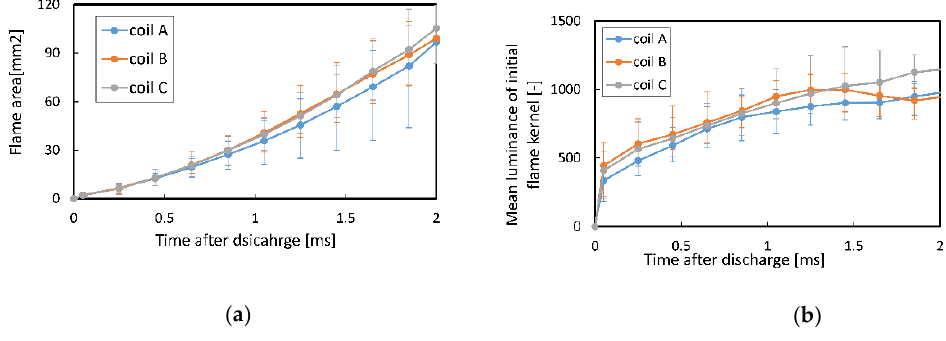
Figure 12. Basic condition: ( a ) Initial flame area; ( b ) Initial flame luminance.